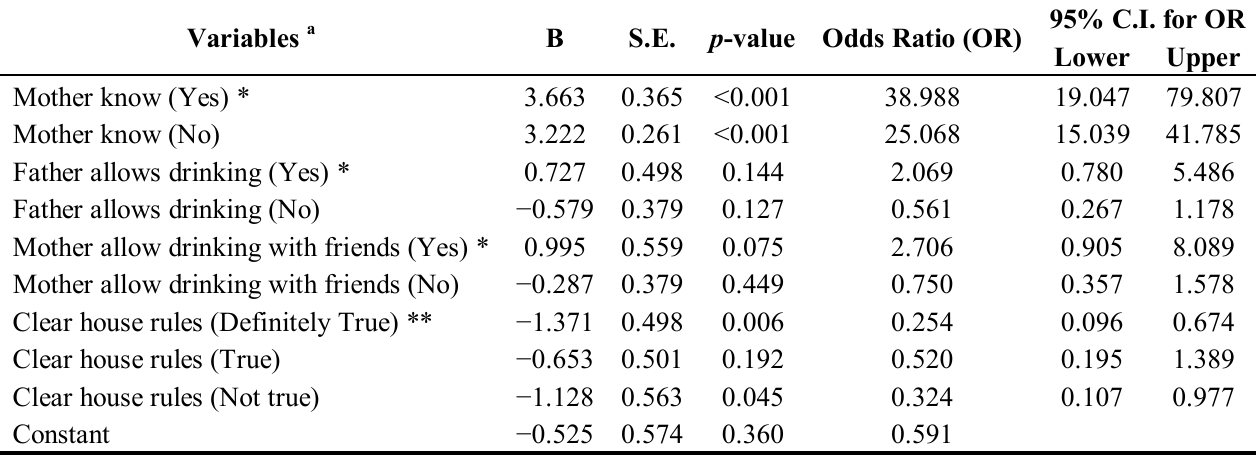
Table 5. Backward stepwise logistic regression output for ever alcohol use among the students. Variables a